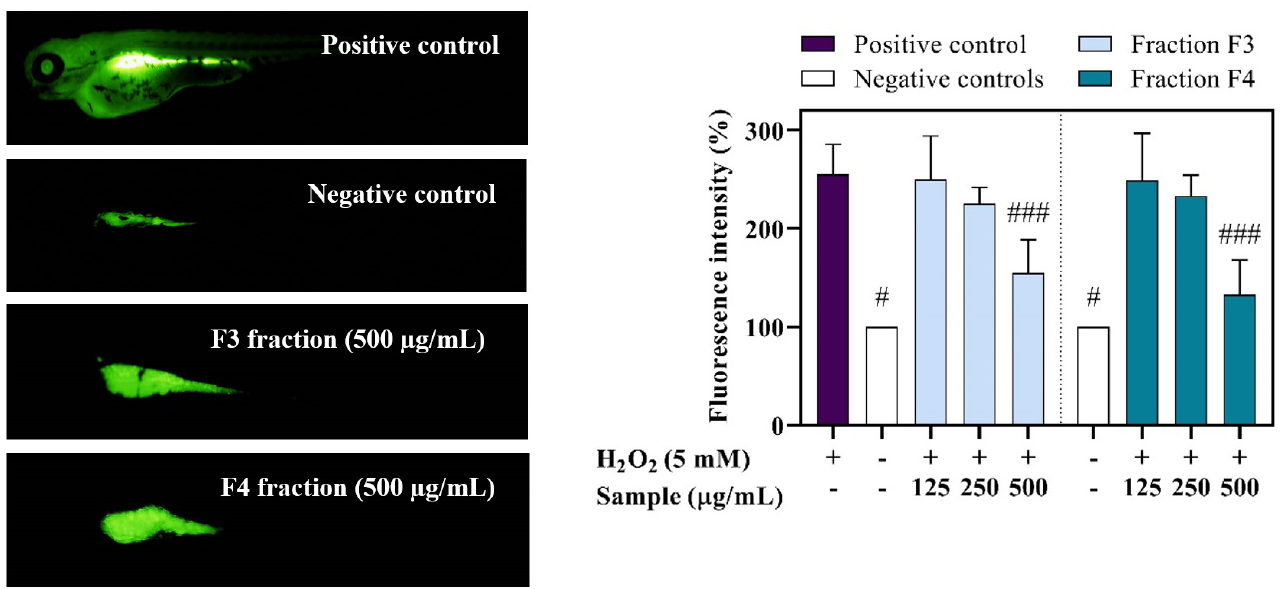
Figure 6. ROS scavenging potential of C. adhaerens fractions F3 and F4 in zebrafish. Left: Representative fluorescence images of H 2 O 2 treated and the fractions co-treated zebrafish larvae. Right: Mean fluorescent intensity of DCF in the whole larvae calculated using Image J program. Sign # represents significant difference when compared with H 2 O 2 -treated group (# p < 0.05; ### p < 0.001). Each treatment was normalised relative to non-treated controls (100%).